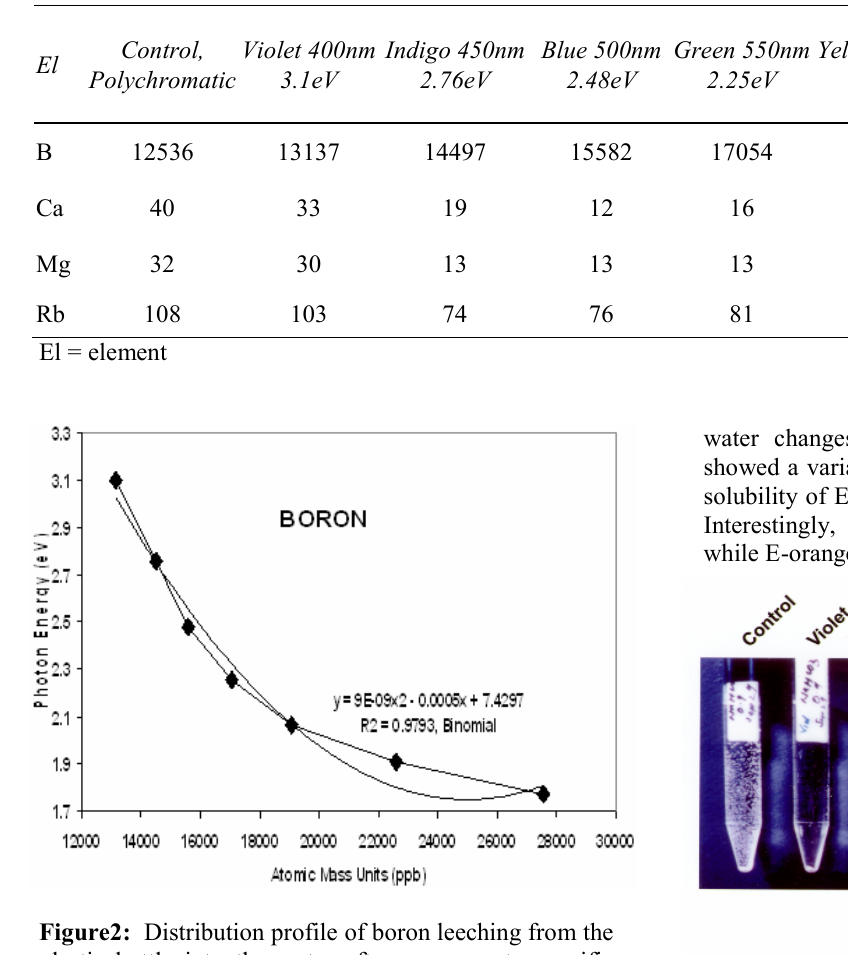
Table 1B: Variation of elements contained in spectral irradiated distilled water as measured by Inductively Couple Plasma Spectroscopy (PPB).